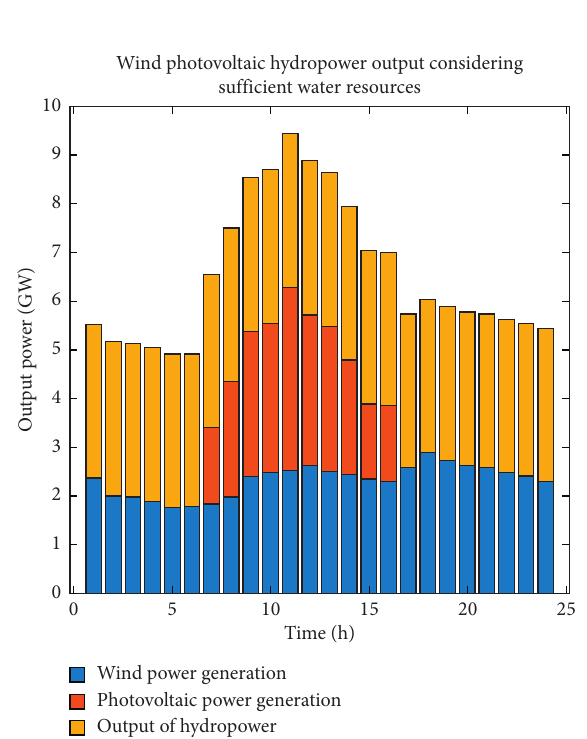
Figure 5: Clean energy output.